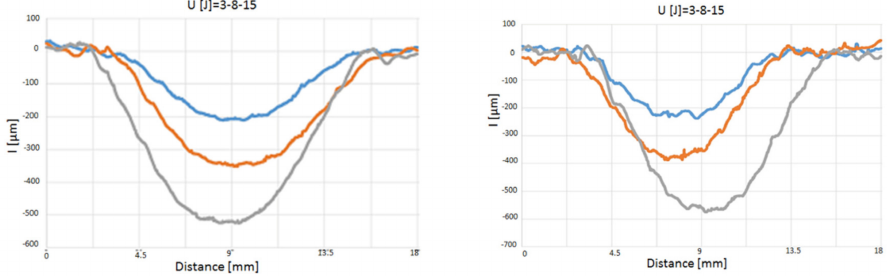
Figure 13. BS-PP and BS-PPC Indentation